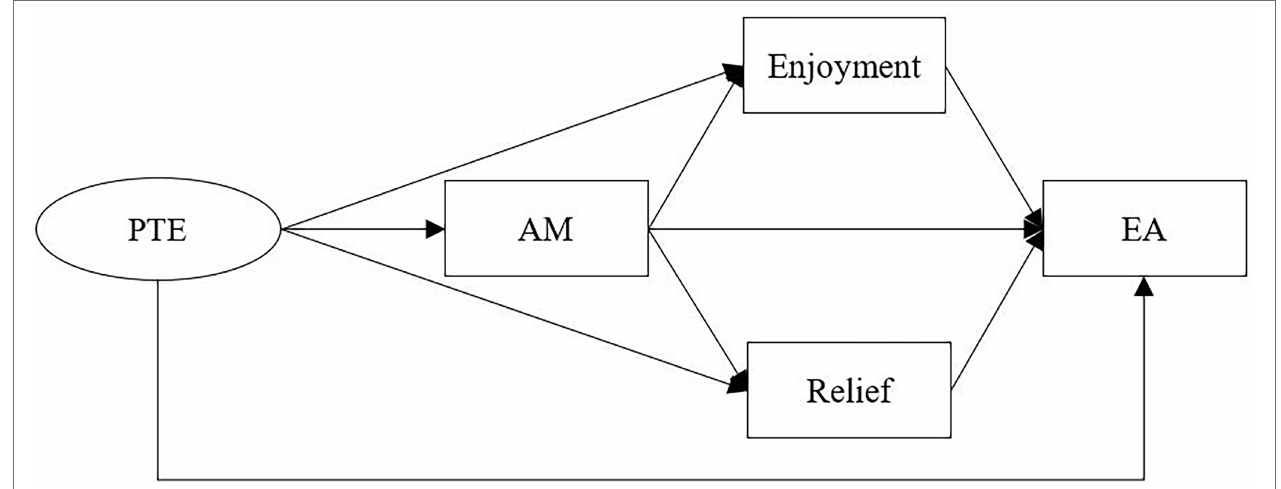
FIGURE 1 | Hypothesized model. PTE, Perceived Teacher Engagement; AM, Autonomous Motivation; EA, English